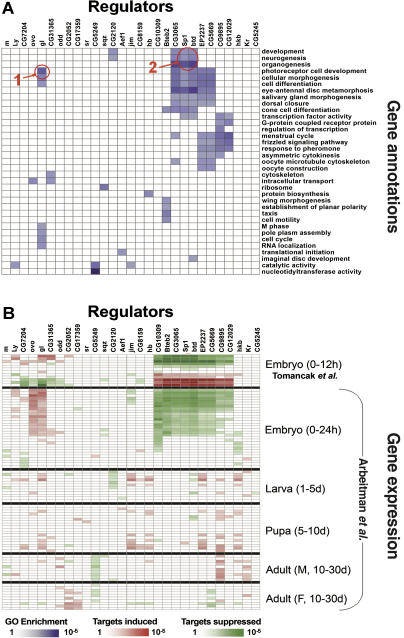
Inferring the Function and Activity of Zinc Finger Transcription Factors in D. melanogaster
(A) Similar gene annotation enrichment among the putative target sets of 29 transcription factors in D. melanogaster. Blue cells correspond to significant overabundance of a GO term (row) among the predicted targets of a protein (column), using a hyper-geometric test. The binding sites of most factors show enrichment in at least one GO term. For some of the regulators, the enriched GO terms match prior biological knowledge. For example, the putative targets of Glass (gl) were found to be enriched with terms related to photoreceptor cell development (red circle 1). Similarly, the putative targets of Buttonhead (btd) and Sp1 were enriched with developmental terms such as neurogenesis, development, and organogenesis (red circle 2). Closely related GO annotations are not shown; see Figure S4 for full results.(B) Deducing the activity of the 29 transcription factors using gene expression patterns. Expression data from early (0–12 h) embryogenesis [20] and data from the entire Drosophila life cycle [21] are used to test whether the putative direct targets of a regulator are expressed differently than the rest of the genes in a given experiment. Red cells correspond to significant enrichment of overexpressed targets using a Kolmogorov-Smirnov test, while green cells correspond to enrichment of underexpressed targets. For most of the regulators the analysis resulted in at least one significant embryogenesis experiment, suggesting an active role in early developmental stages (above). Similar results were obtained using the full life cycle gene expression data (below).